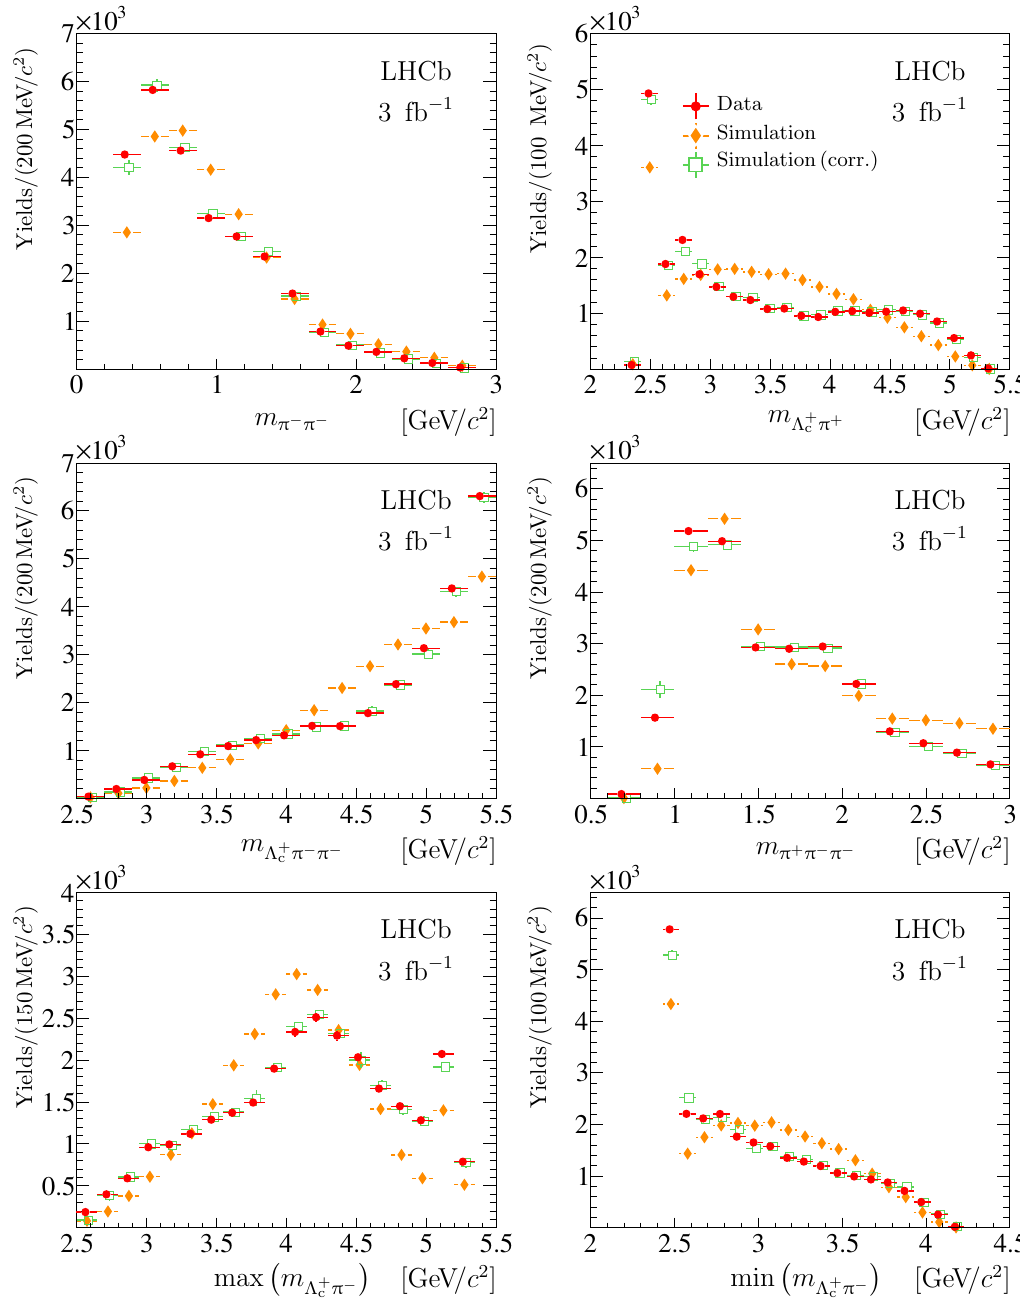
Figure 10 . Background-subtracted π − π − , Λ + minimum Λ + π − mass spectra for the Λ 0 c corrected (corr.) simulation are